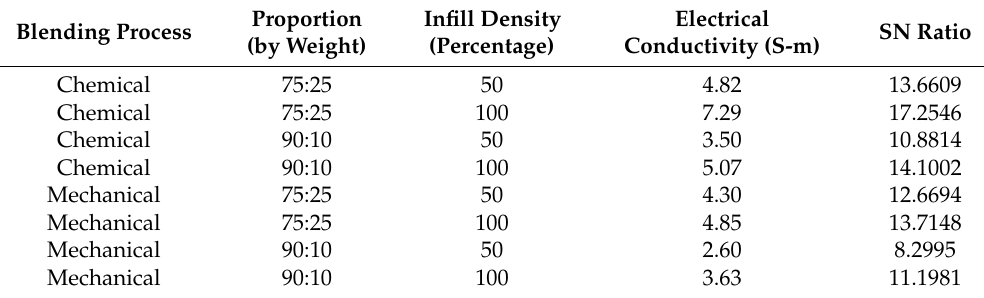
Table 4. Electrical conductivity of tested sample with SN